Question: What does this figure show? Answer in one sentence.
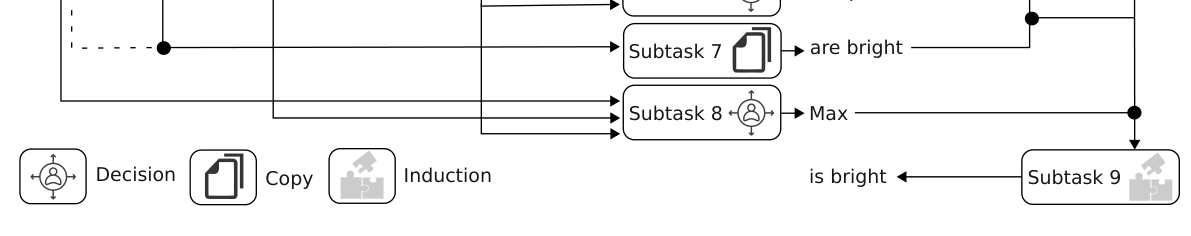
Answer: An working example of task decomposition of CoT generation on fictional ontology. Decision-type subtasks (0, 2, 4, 6, and 8) choose which reasoning path to follow; such decisions may be about the order of the information to be copied from the question to the generated output or whether inductive reasoning will be performed. Copy-type subtasks (1, 3, and 7) follow Decision subtasks and copy statements from the context to output. Induction-type subtasks (5 and 9) perform the reasoning steps of the form “if A is B and B is C, then A is C”.